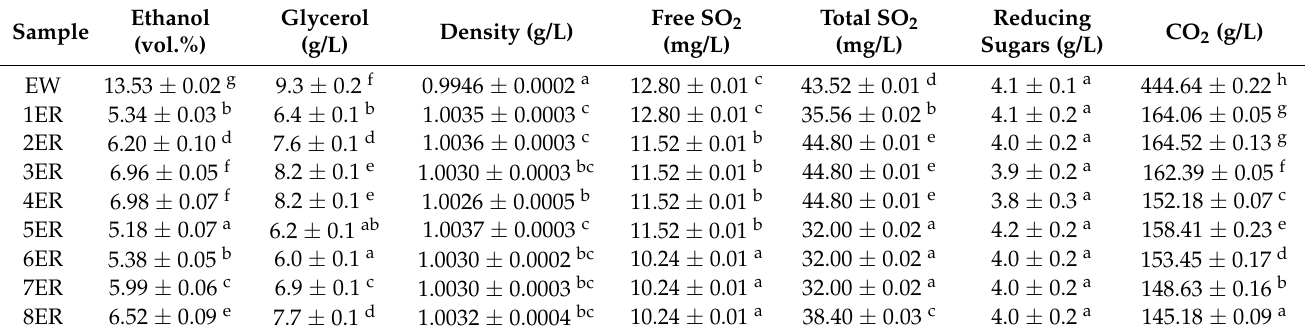
Table 4. Chemical composition of the initial ecological Cabernet Sauvignon wine and the reverse osmosis retentates at 2.5, 3.5, 4.5 and 5.5 MPa, with cooling and without